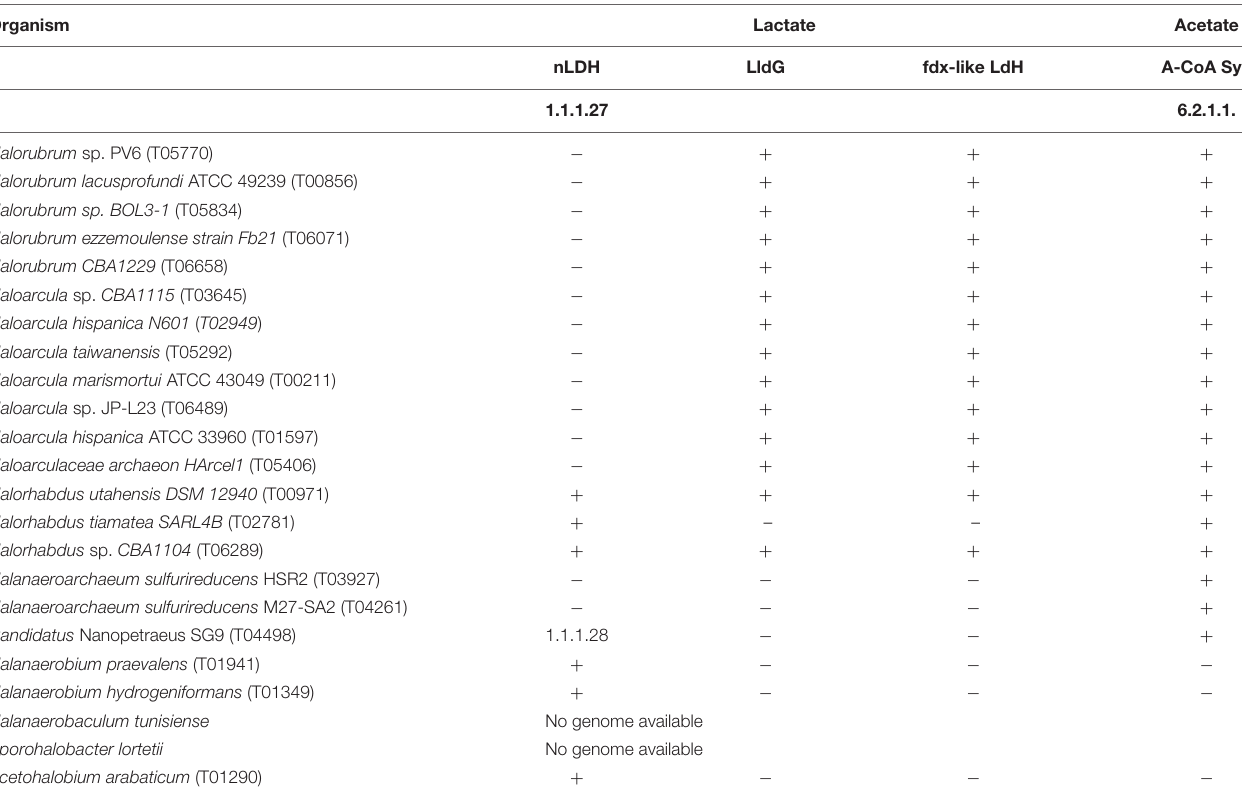
The closed match and the closest identified type strain (in the case of unknown organisms) are indicated. Accession numbers are included. TABLE 4A | Presence or absence of genes coding for the indicated enzymes related to the utilization of lactate or acetate in the genome of listed organisms.